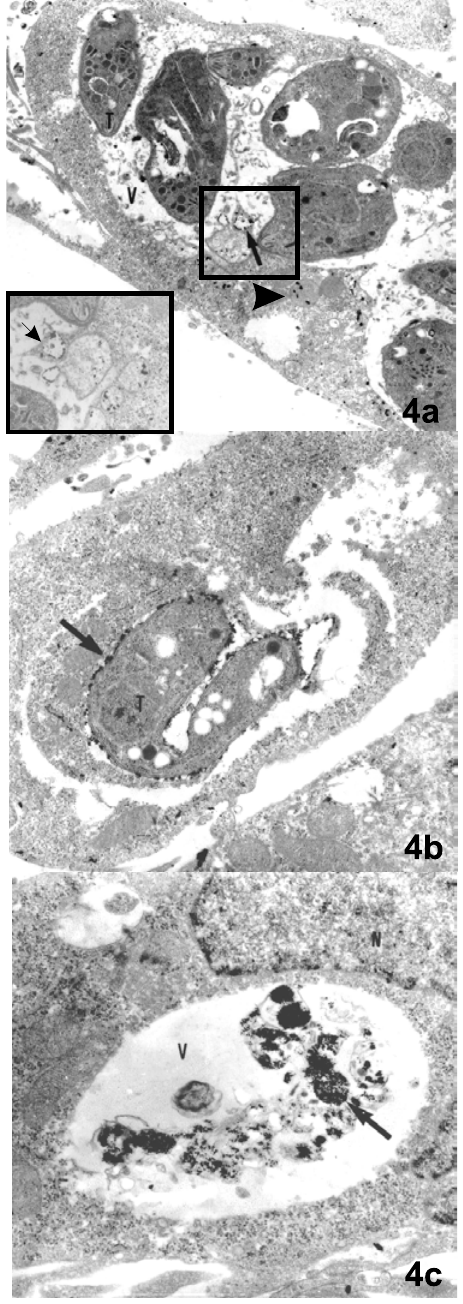
Fig. 4 – Transmission electron microscopy of Vero cells subjected to the acidic phosphatase technique. In the presence of hydroxyurea for 12h, infected cells showed reaction product in cytoplasm (fig. 4a – arrowhead) or in the vesicle fusing with PV (fig. 4a, inset – arrow). After 24h of incubation with the drug the reaction product could be observed on parasite surface (fig. 4b – arrow) or associates with disrupted parasites (fig. 4c – arrow) when the infected cells were incubated for 48h. Tachyzoites: T; Parasitophorous vacuole: V; Nucleus: N. Figure 4a = x7000; inset = x12000; Figure 4b = x12000; Figure 4c = x20000.